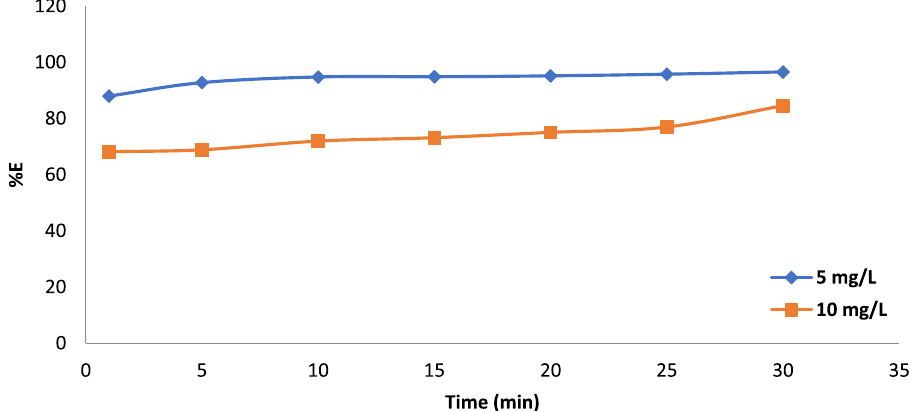
Figure 5. Influence of contact time on biosorptive removal of BF dye by Gel@GO-F-ZrSiO 4 @Gel. Removal efficiency values (%) are based on triplicate analysis with ± 0.1–0.5% (shaking time = 1–30 min. dye